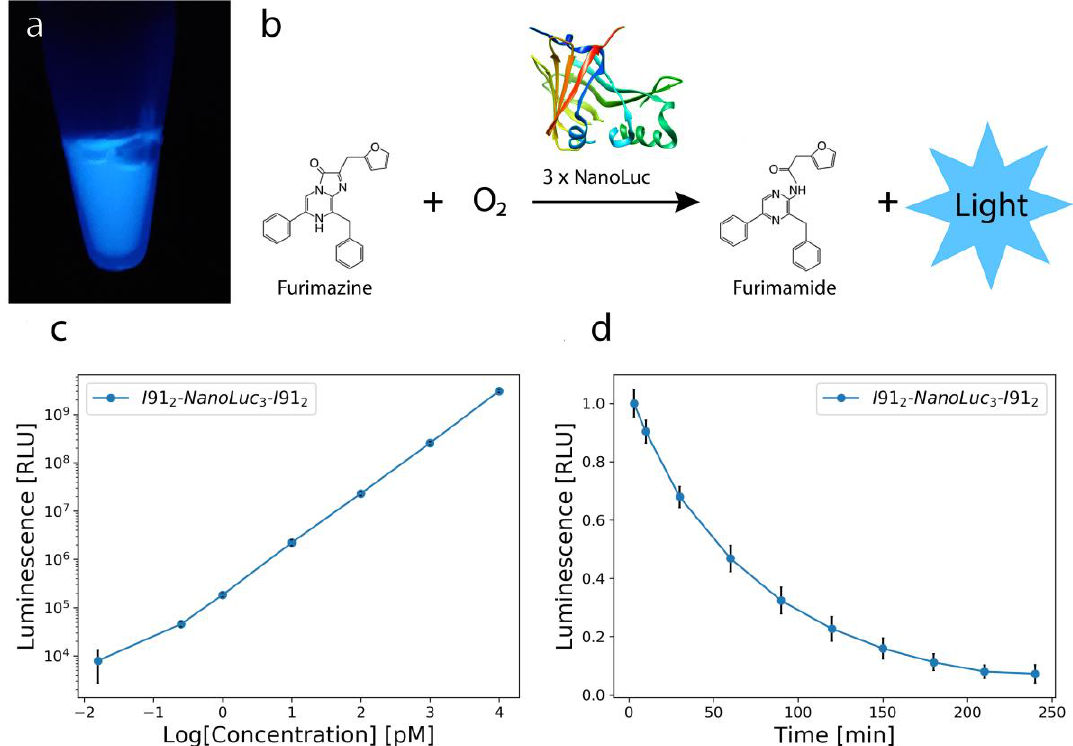
Figure 1. ( a ) Bioluminescence of 50 μL 206 nM I91 2 -NanoLuc 3 -I91 2 after mixing with 50 μL Nano-Glo Luciferase Assay Buffer. The Assay Buffer contains NanoLuc’s substrate, furimazine. (Imaged by mobile phone) ( b ) ATP-independent bioluminescence reaction catalyzed by NanoLuc during which the substrate (furimazine) is oxidized into furimamide (inspired by Promega company sketch) [86]. ( c ) Bioluminescence results of I91 2 -NanoLuc 3 -I91 2 construct showing dilutions of 10 nM to ~16 fM vs. logarithmic concentration of the protein. ( n = 3). ( d ) Normalized time dependence of bioluminescence vs. time of 10 nM I91 2 -NanoLuc 3 -I91 2 construct ( n = 4). The mean values were plotted along with the standard error of the mean for the normalized values for both ( c ) and ( d ) (black vertical lines). All measurements were at room temperature.